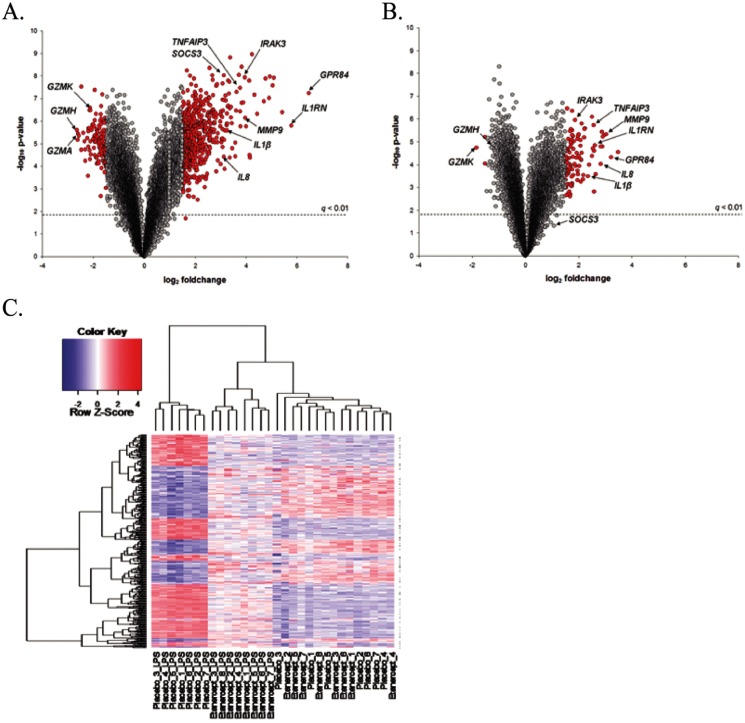
Genomic analysis of the systemic LPS-induced transcriptional response and impact of TNFα inhibition.
A. Volcano plot analysis (integrating p-values and log2 foldchanges) for the LPS-induced response in subjects treated with placebo. B. Volcano plot analysis of the LPS-induced response in subjects treated with the TNFα antagonist etanercept. Red dots in panels A and B indicate probes that showed a fold-change ≥1.5 or ≤1.5. C. Unsupervised hierarchical clustering heatmap of the 4077 LPS-induced transcripts that were influenced by etanercept treatment as identified by ANOVA (q-value <0.05). Columns represent subject samples and rows represent transcripts. Red indicates increased gene expression, and blue indicates decreased gene expression.